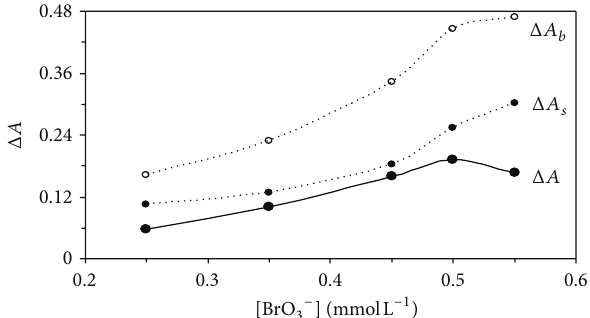
Figure 3: Effect of bromate concentration on the rate of unin- hibited ( Δ𝐴 𝑏 ) and inhibited ( Δ𝐴 𝑠 ) reactions and response ( Δ𝐴 ). (Conditions: sulfuric acid, 0.40 mmolL −1 ; thionine, 30.0 𝜇 molL −1 ; dopamine, 3.0 𝜇 g mL −1 ; bromate, 0.25–0.55 mmolL −1 ; 25 ∘ C and 270